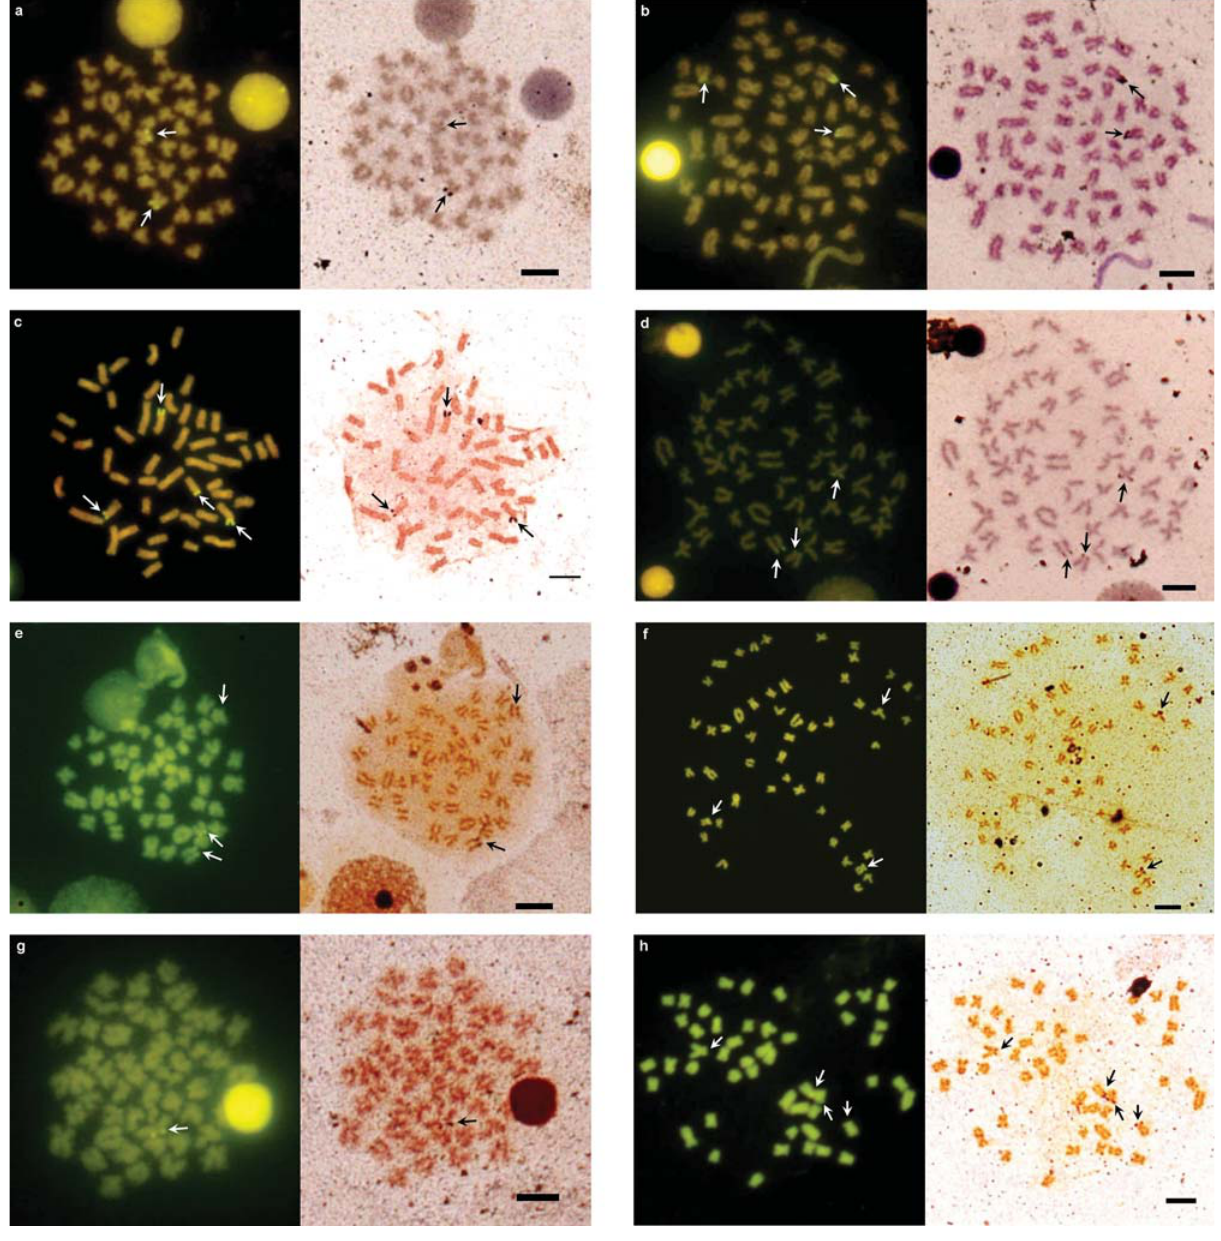
Figure 3 - Sequential banding with CMA 3 /Ag in specimens of Iberochondrostoma lusitanicum : ( a ) Samarra, male, two CMA 3 /Ag-NORs; ( b ) Samarra, triploid female, three CMA 3 - and two Ag-NORs; ( c ) Tejo1, female, four CMA 3 - and three Ag-NORs; ( d ) Tejo2, female, three CMA 3 /Ag-NORs; ( e ) Junqueira, juvenile, three CMA 3 - and two Ag-NORs; Sequential banding with CMA 3 /Ag in specimens of Iberochondrostoma almacai : ( f ) Monchique, juvenile, three CMA 3 - and two Ag-NORs; ( g ) Odelouca, juvenile, one CMA 3 /Ag-NOR; ( h ) Torgal, juvenile, four CMA 3 /Ag-NORs. Arrows indicate the CMA 3 /Ag-NORs positive sites. The bar corresponds to 5 (cid:2)